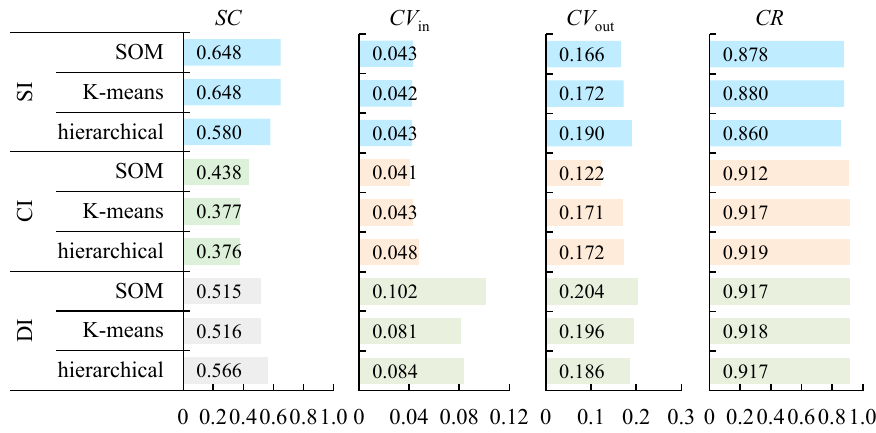
Figure 3. Evaluation of clustering methods under different indexes with different colors.